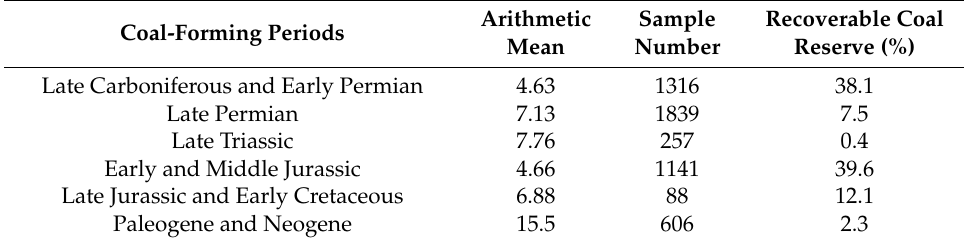
Table 5. Arsenic concentration in coals of different coal-forming periods in China